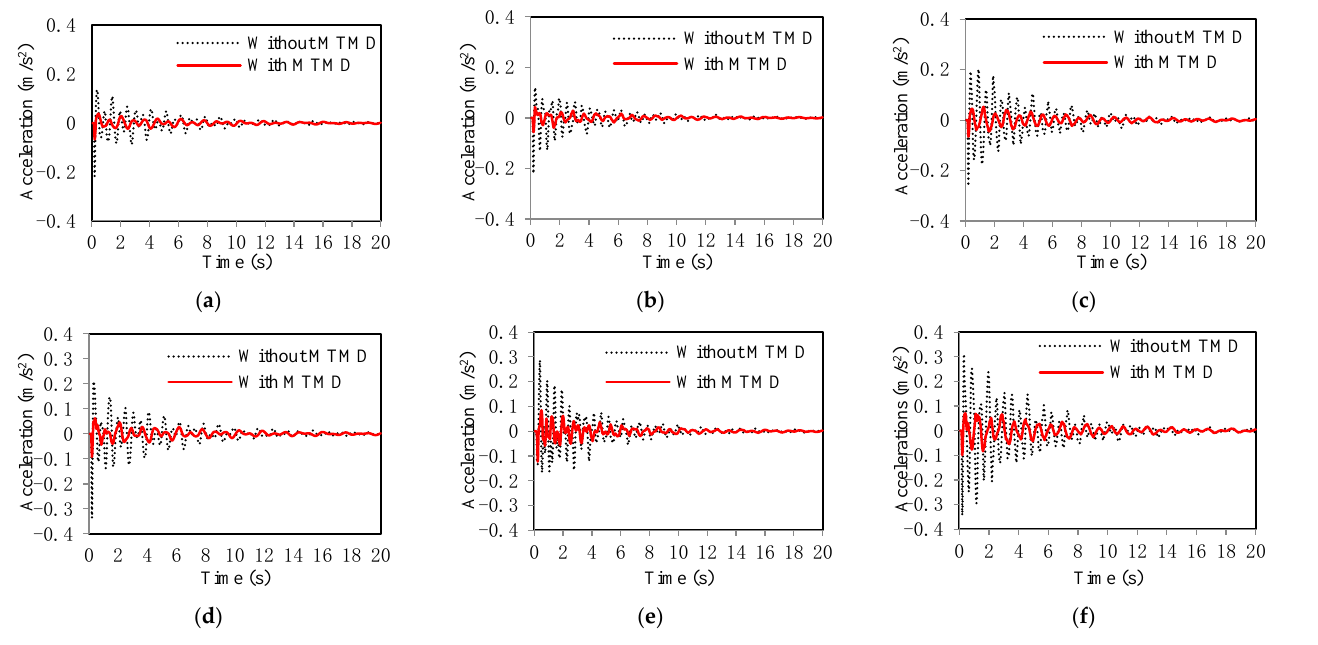
Figure 8. Results of lateral accelerations: ( a ) the first span in Case I; ( b ) the second span in Case I; ( c ) the third span in Case I; ( d ) the first span in Case II; ( e ) the second span in Case II; and ( f ) the third span in Case II.